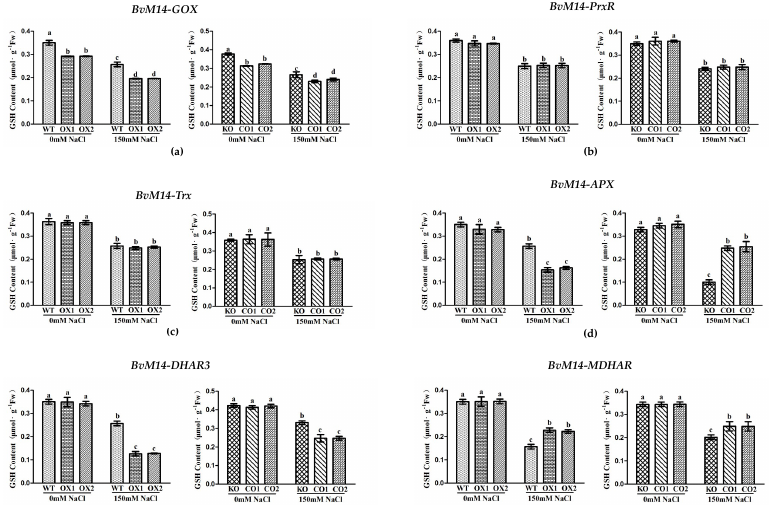
Figure 4. The GSH contents of WT and GOX , PrxR , Trx , APX , DHAR3 , and MDHAR transgenic plants under salt stress: ( a ) GOX- related; ( b ) PrxR- related; ( c ) Trx- related; ( d ) APX- related; ( e ) DHAR3- related; ( f ) MDHAR- related plants. Data were analyzed by Duncan’s analysis of variance, and different lowercase letters (a, b, c, d) indicate differences in GSH contents.